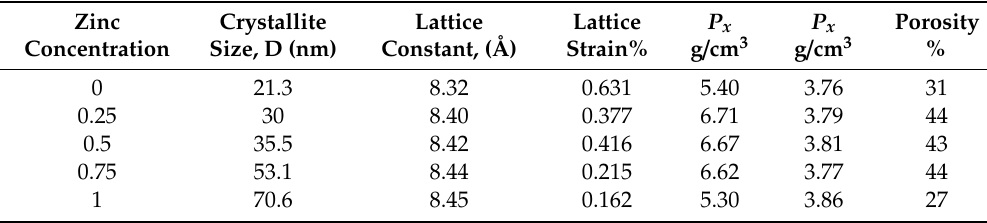
Table 1. Crystallite size, lattice constant, and lattice strain for Ni 1 − x Zn x Fe 2 O 4 .